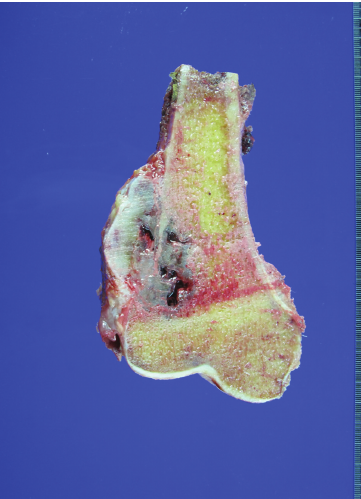
Figure 2: An intramedullary cartilaginous mass, measuring 9.5cm in greatest dimension, in the metadiaphysis of proximal femur. Note the white to bluish gray and lobulated cut surface and cortical